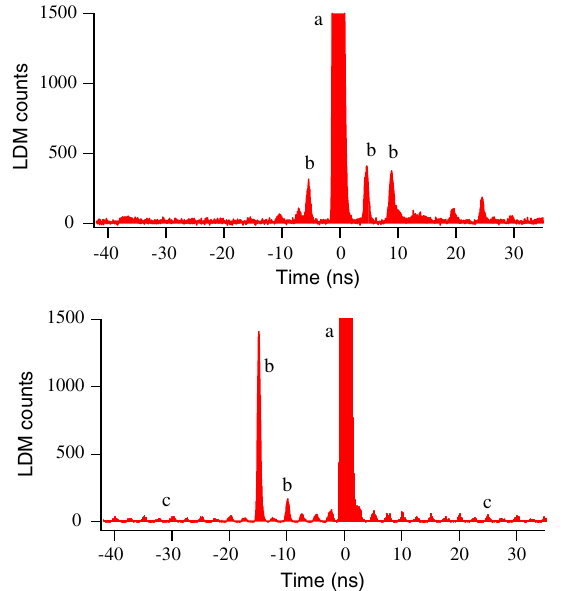
FIG. 6. Typical pattern of satellites in an LHC fill with protons (above) and with lead ions (below) showing (a) main bunch with peak at 1 : 3 (cid:3) 10 5 counts, (b) satellites, and (c) ghost